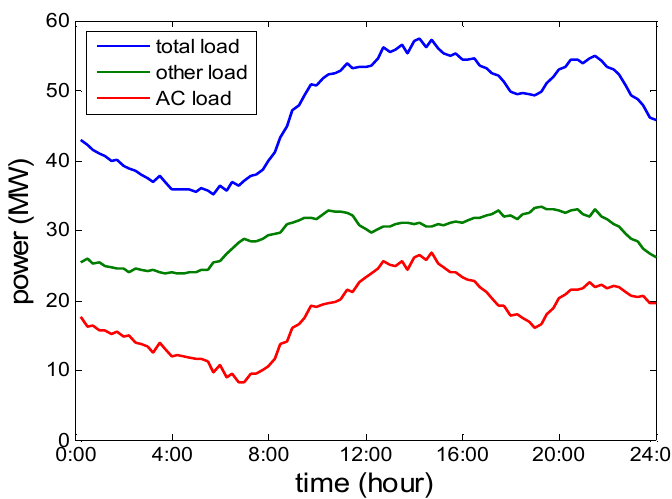
Figure 19. 24 h power load of a downtown area of Nanjing, China where there are 18,000 ACs of 10,000 residents operating on the hot day 5 August